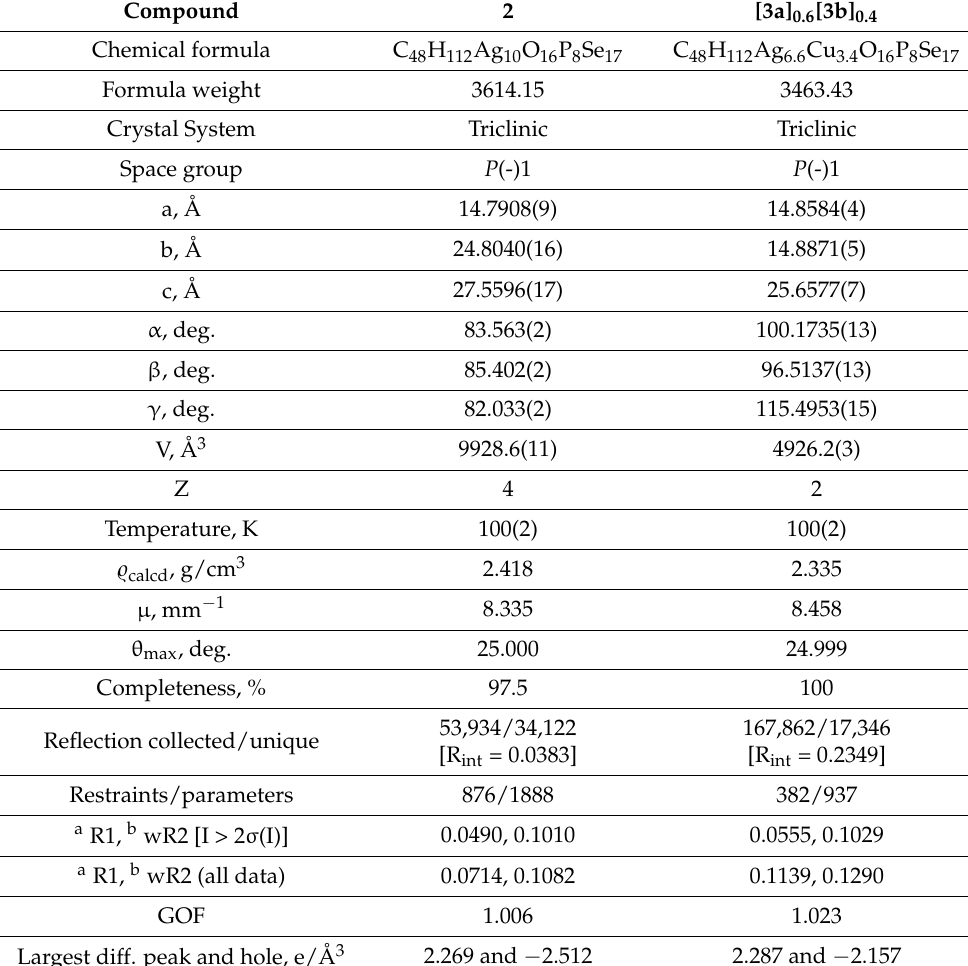
Table 3. Selected X-ray crystallographic data of 2 and [ 3a ] 0.6 [ 3b ] 0.4 .